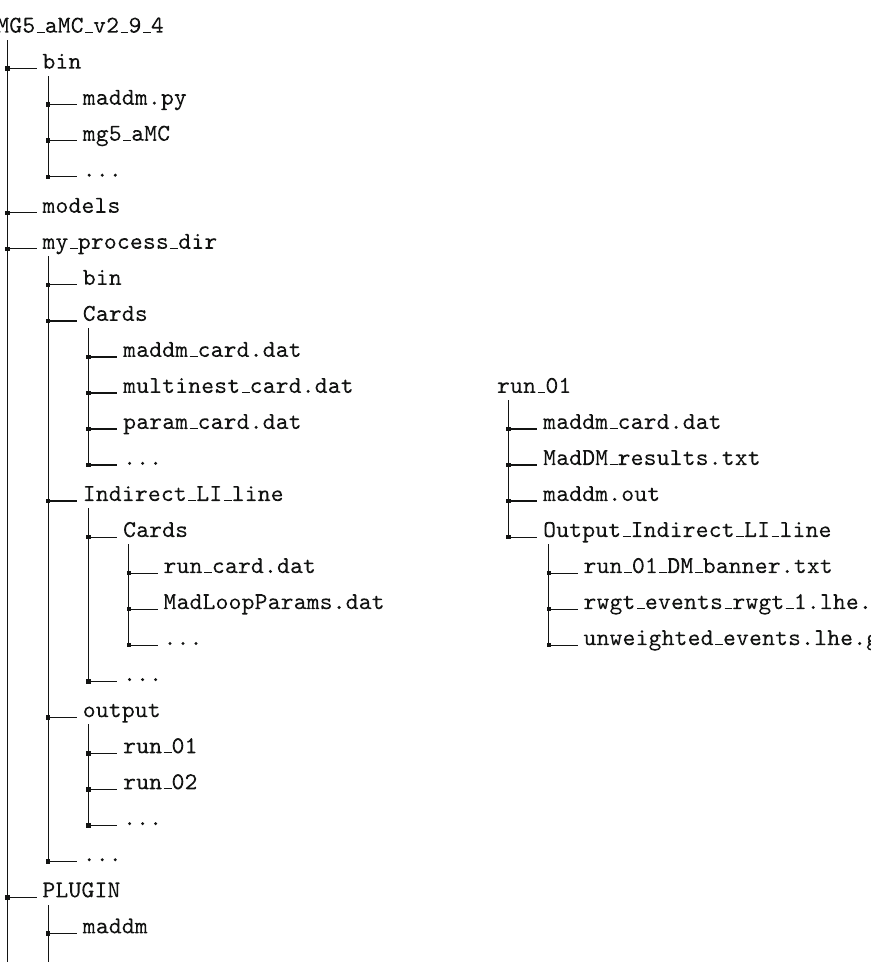
Fig. 3 Schematic structure